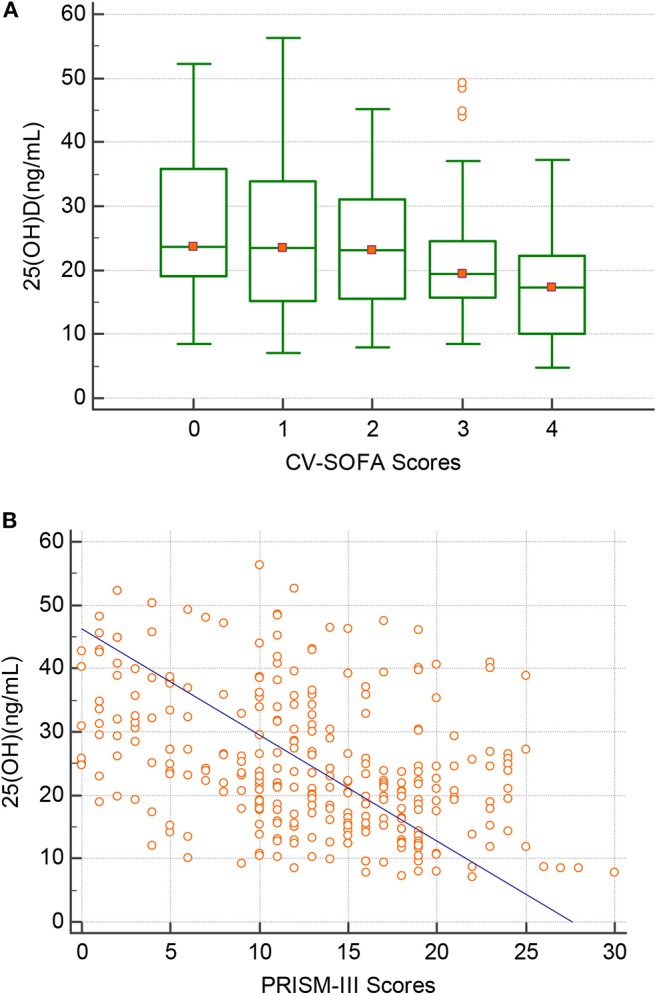
Correlation between the 25(OH)D level(Y-axis) and (A) the maximum cardiovascular SOFA (CV-SOFA) (X-axis) (r = −0.193, P = 0.0008) during the ICU stay and (B) the PRISM-III score(X-axis) (r = −0.397, P = 0.0001) at PICU admission in critically ill children.